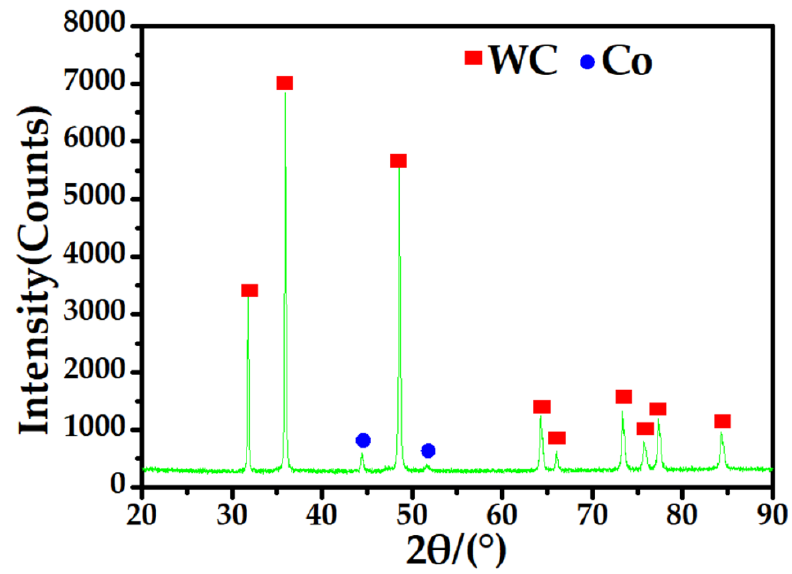
Figure 6. The X-ray diffraction (XRD) patterns of conventional WC-17Co